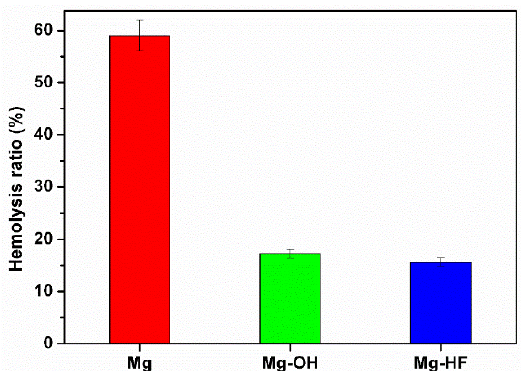
Figure 6. The hemolysis rate for different samples. Three parallel samples were measured and the data were averaged and expressed as mean ± SD. The hemolysis rates of the modified samples were significantly lower ( p < 0.05) than that of the unmodified magnesium alloy. There was no significant difference ( p > 0.05) between Mg–OH and Mg–HF.